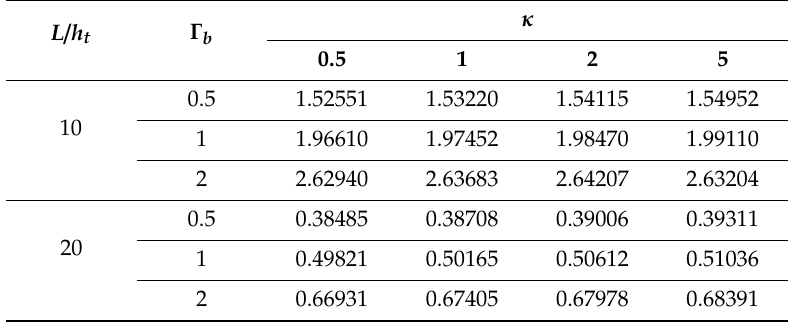
Table 5. First-order nonlinear-to-linear frequency ratio of a simply supported GPL-reinforced